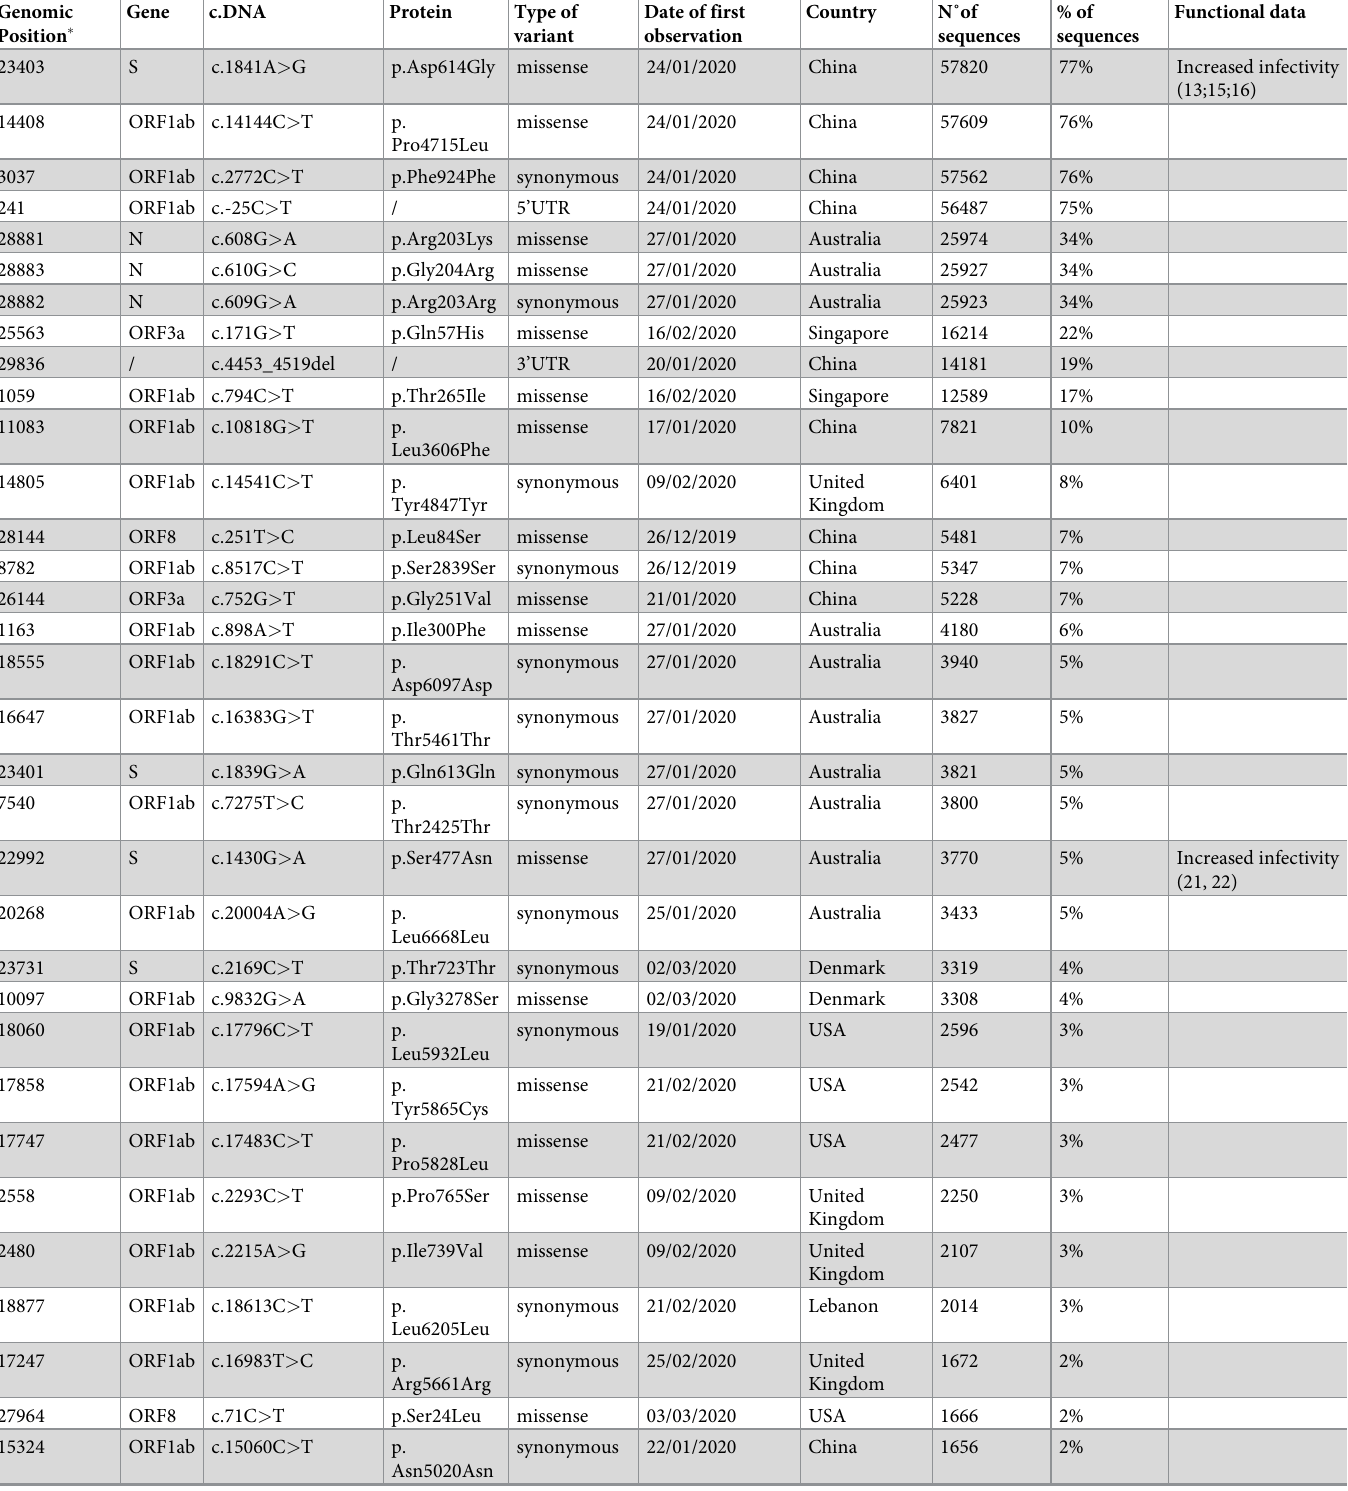
Table 2. Most frequent SARS-CoV-2 variants. Only the variants identified in at least 1000 viral sequences are reported. Genomic Position